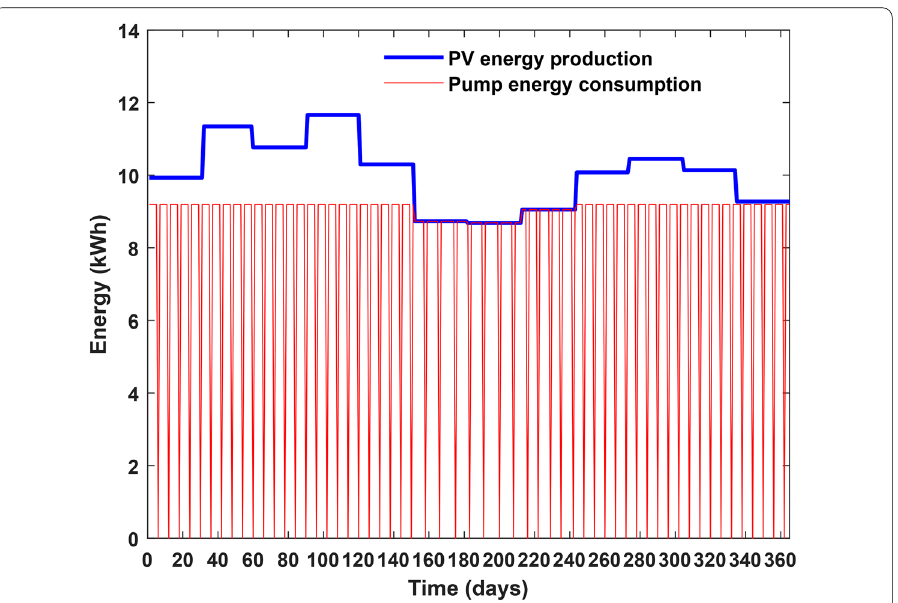
Fig. 10 Comparison between daily variation in energy production and energy consumption over one year for the optimal configuration corresponding to LWSP of